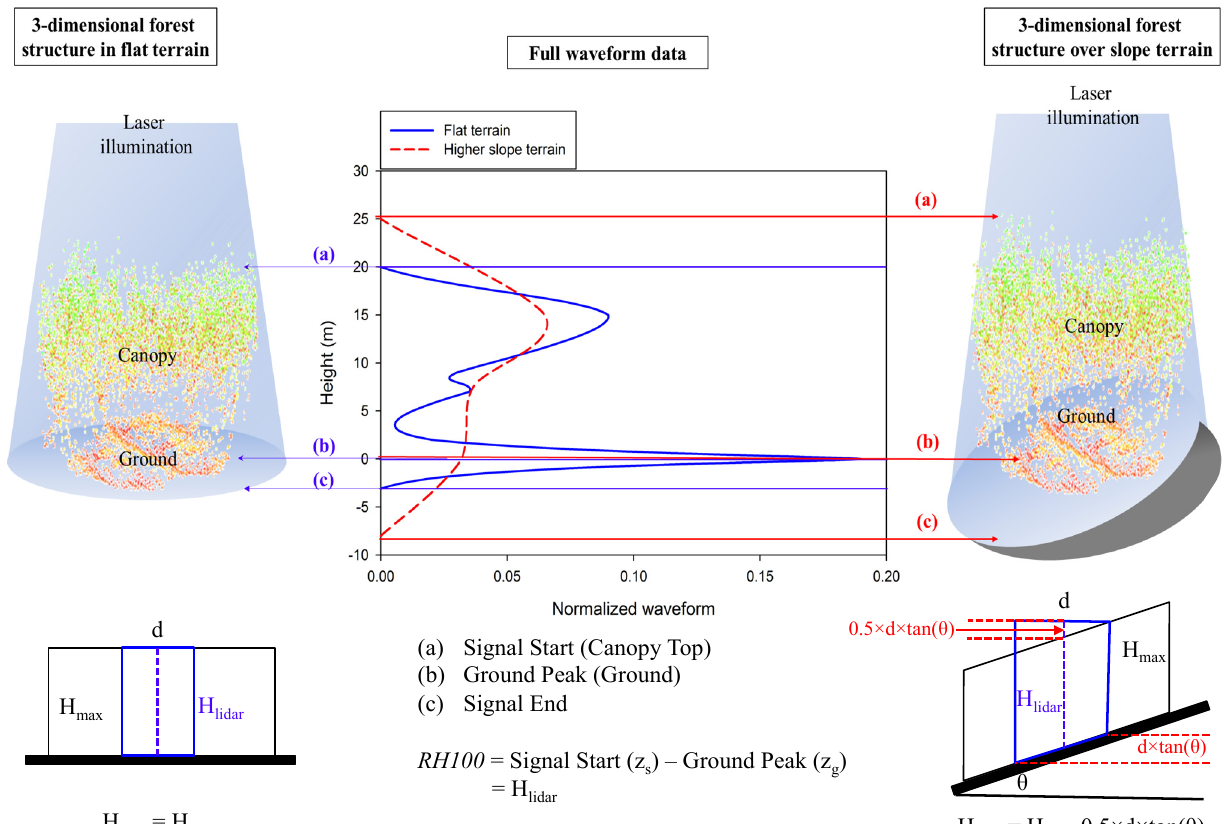
Figure 3. Schematic definitions of actual maximum forest canopy height and lidar-derived maximum canopy height for a waveform over the flat (solid blue line) and slopped (dash red line) terrains. Lower left and right panels demonstrate impact of terrain slope on lidar height retrieval. H is actual maximum canopy height and H (= RH100 ) is max lidar lidar-derived maximum canopy height. d is lidar footprint diameter, and θ is the terrain